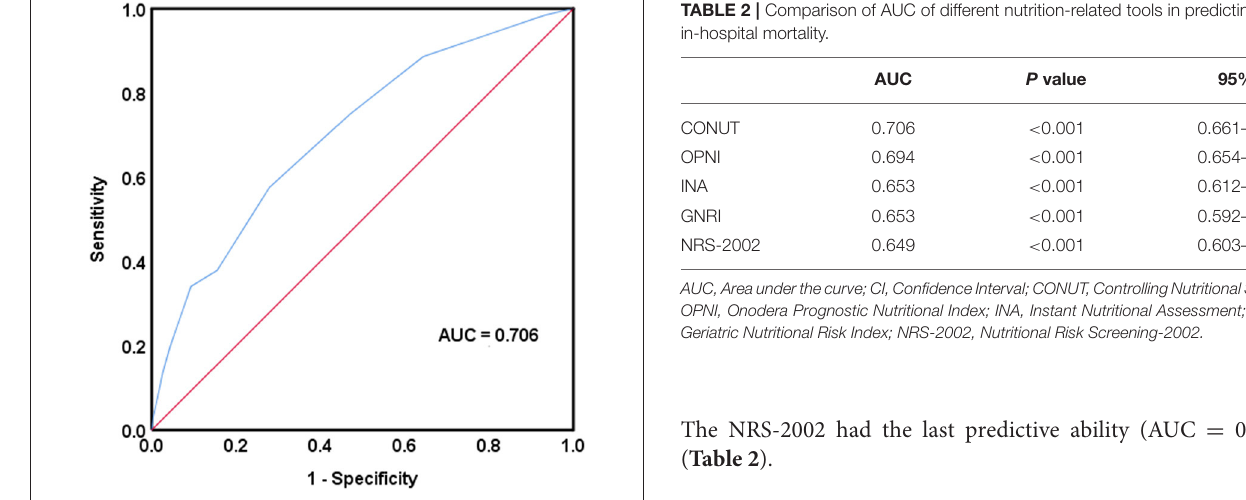
FIGURE 2 | Receiver operating characteristic curve analysis was used to assess the accuracy of the controlling nutritional status score in predicting in-hospital mortality. AUC, area under the curve.